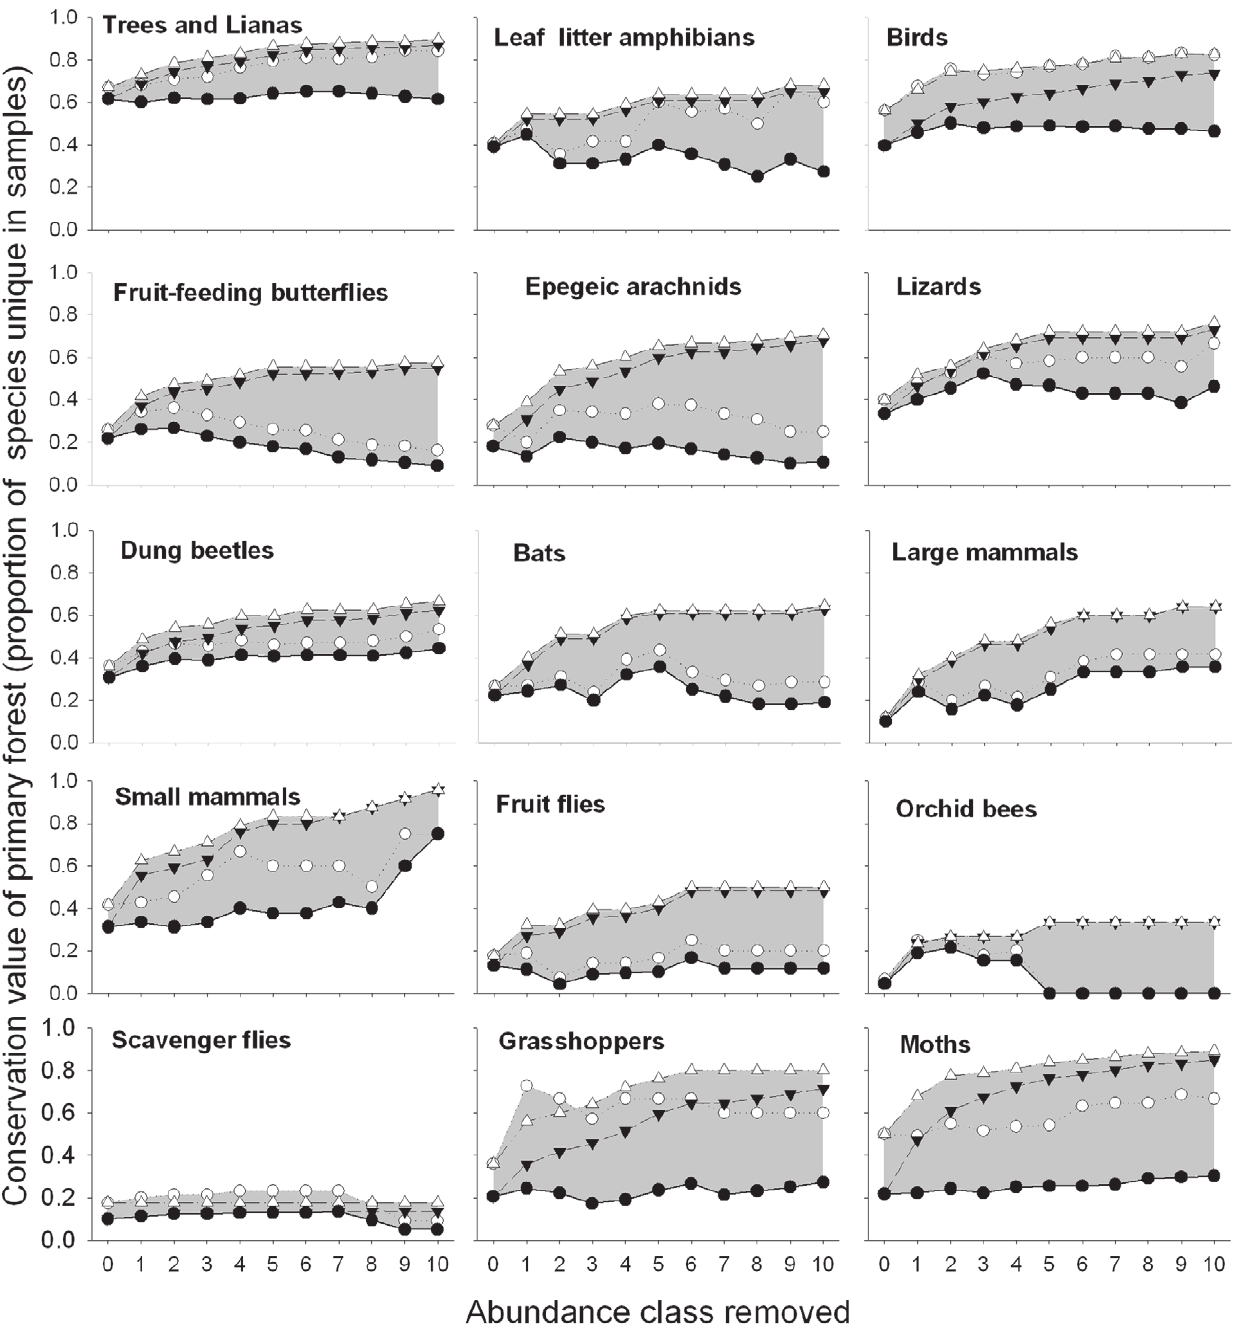
Figure 2. The conservation value of primary forest (measured as the proportion of species unique to primary forest samples) for 15 vertebrate, invertebrate and plant taxa, following the sequential removal of abundance classes. Lines within each panel show different selection criteria and removal rules, and the grey shaded area indicates the region between the upper and lower estimates of uniqueness. Circles represent values when occasional species are removed from all forest types simultaneously, and triangles represent the removal of occasional species from modified forest types only. Solid and open symbols represent the proportion of the entire species pool, and the proportion of primary forest species (i.e. only species that were recorded in primary forest), respectively. Order of panels follows Barlow et al .